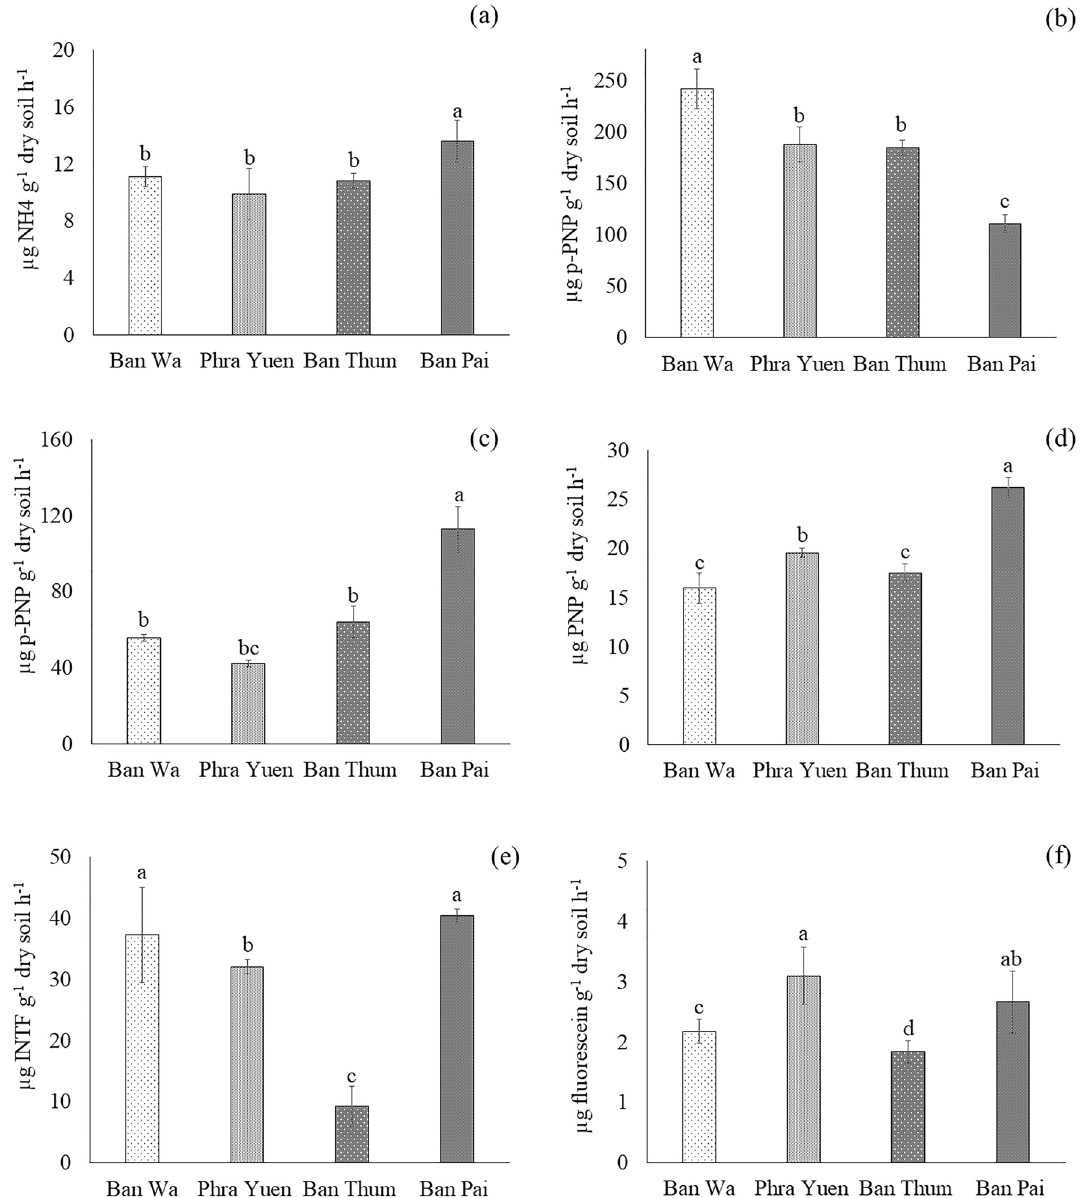
Figure 2. Enzyme activities in rhizosphere soils of ‘RD6’ rice grown in saline rice fields located in four areas in Khon Kaen province, Thailand. ( a urease, b acid phosphatase, c alkaline phosphatase, d arylsulfatase, e dehydrogenase, f fluorescein diacetate hydrolase). Different letters represent significant differences at p < 0.05 according to LSD